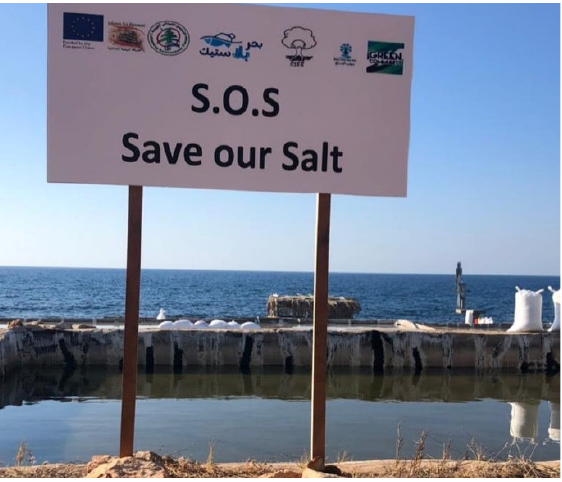
Figure 2. Key partner NGOs on site.